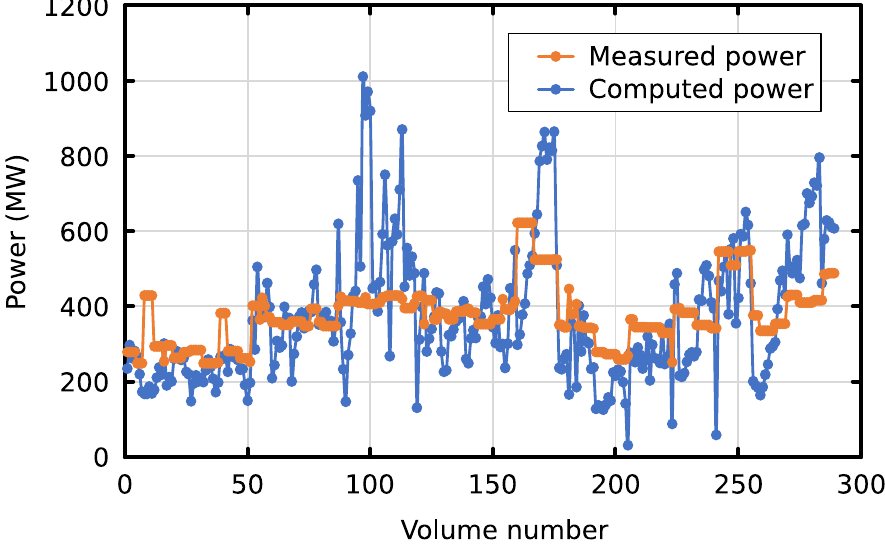
Figure 8. Comparison of power output between 289 simulated and observed data.